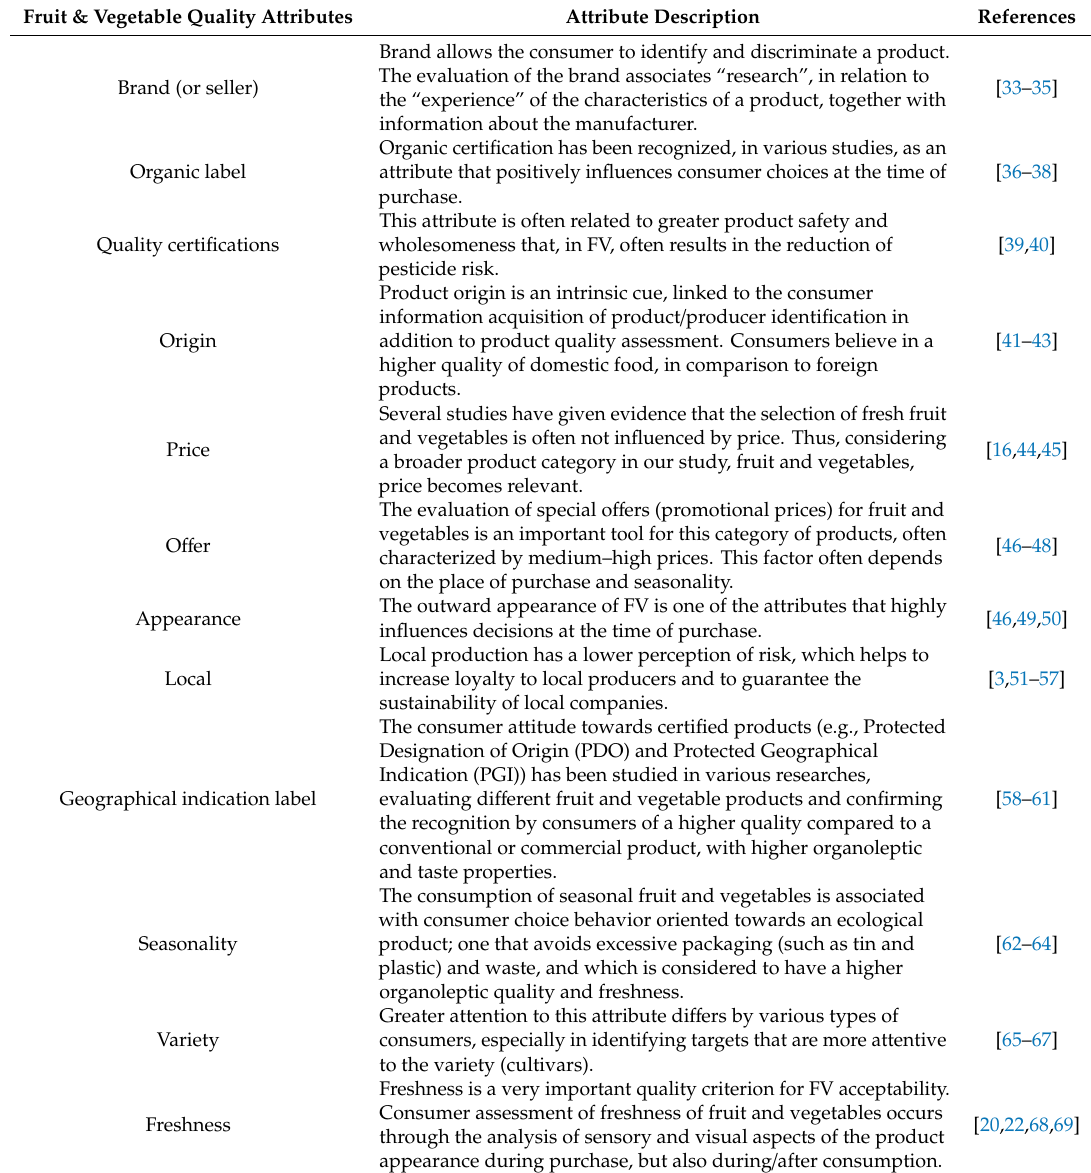
Table 1. The 12 attributes of fruits and vegetables used for the best–worst scaling analysis and associated